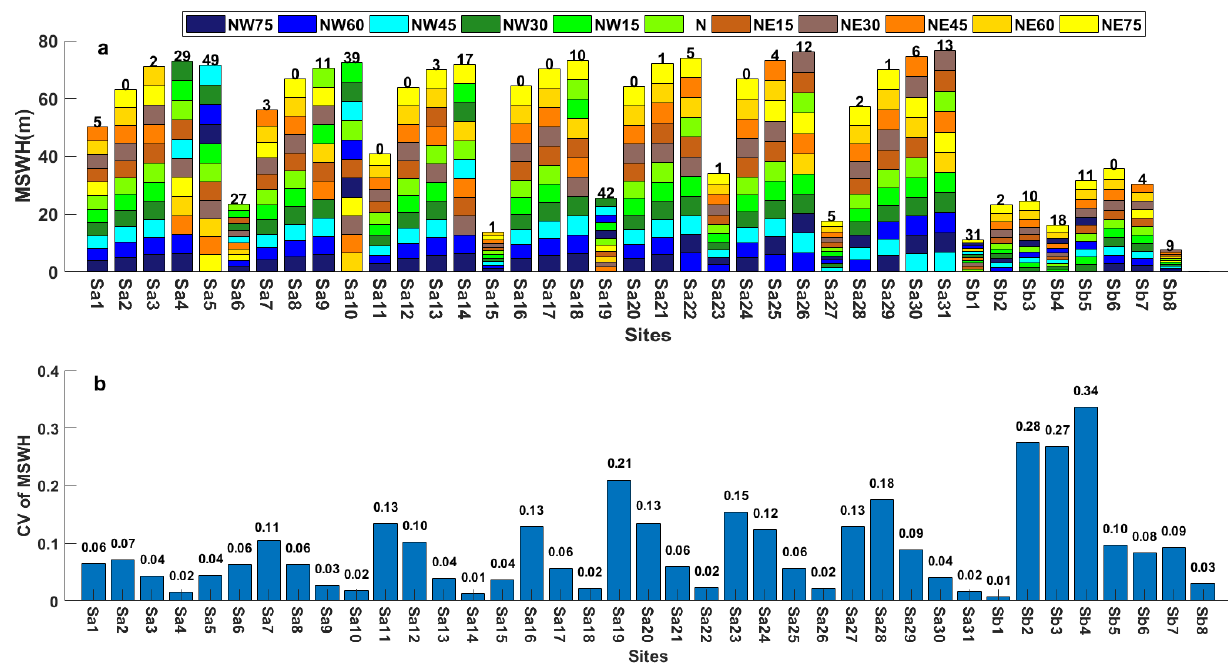
Figure 14. ( a ) MSWH under different wind directions of 39 stations (the larger respective MSWH is at the top of each histogram). MSWH occurring at each station under eleven wind conditions, arranged in the order from 75° N.W to 75° N.E. The inversion number of these permutations was marked at the top of the stacked histogram. ( b ) The coefficients of variation (CV = SD/mean) were obtained by calculating the MSWH that occurred during the eleven cold fronts at each station.